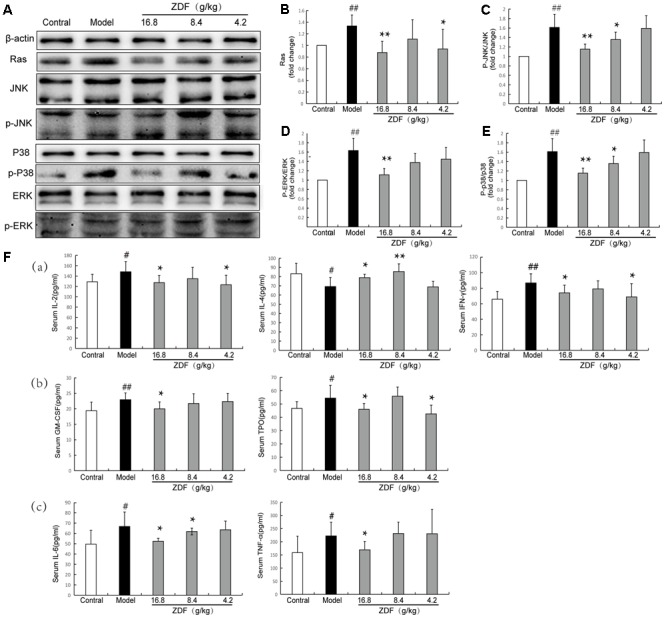
Western blot and ELISA studies. (A) Representative western blots of Ras, JNK, p-JNK, p38, p-p38, ERK, and p-ERK proteins. (B–E) Relative Ras protein expression level and p-JNK/JNK, p-p38/p38, p-ERK/ERK ratios in the experimental animal groups. (F) ELISA evaluation of serum concentrations of IL-2, IL-4, IFN-γ, GM-CSF, TPO, TNF-α, and IL-6 in experimental animal groups. (a) Immunity-related indexes: IL-2, IL-4, and IFN-γ. (b) Proliferation-related indexes: TPO and GM-CSF. (c) Inflammation-related indexes: TNF-α and IL-6. #P < 0.05, ##P < 0.01, compared with the control group; ∗P < 0.05, ∗∗P < 0.01, compared with the model group.